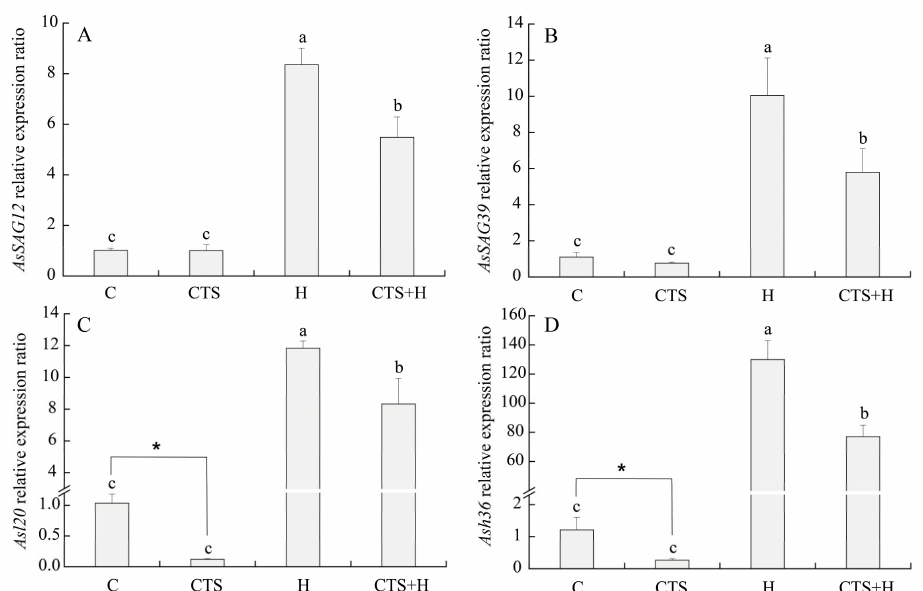
Figure 8. Effect of chitosan on the relative expression levels of ( A ) AsSAG12 , ( B ) AsSAG39 , ( C ) Asl20 , and ( D ) Ash36 under control and heat stress conditions. Vertical bars above columns indicate ± standard error (SE) of means ( n = 4) and different letters above columns indicate significant differences among treatments ( p ≤ 0.05).